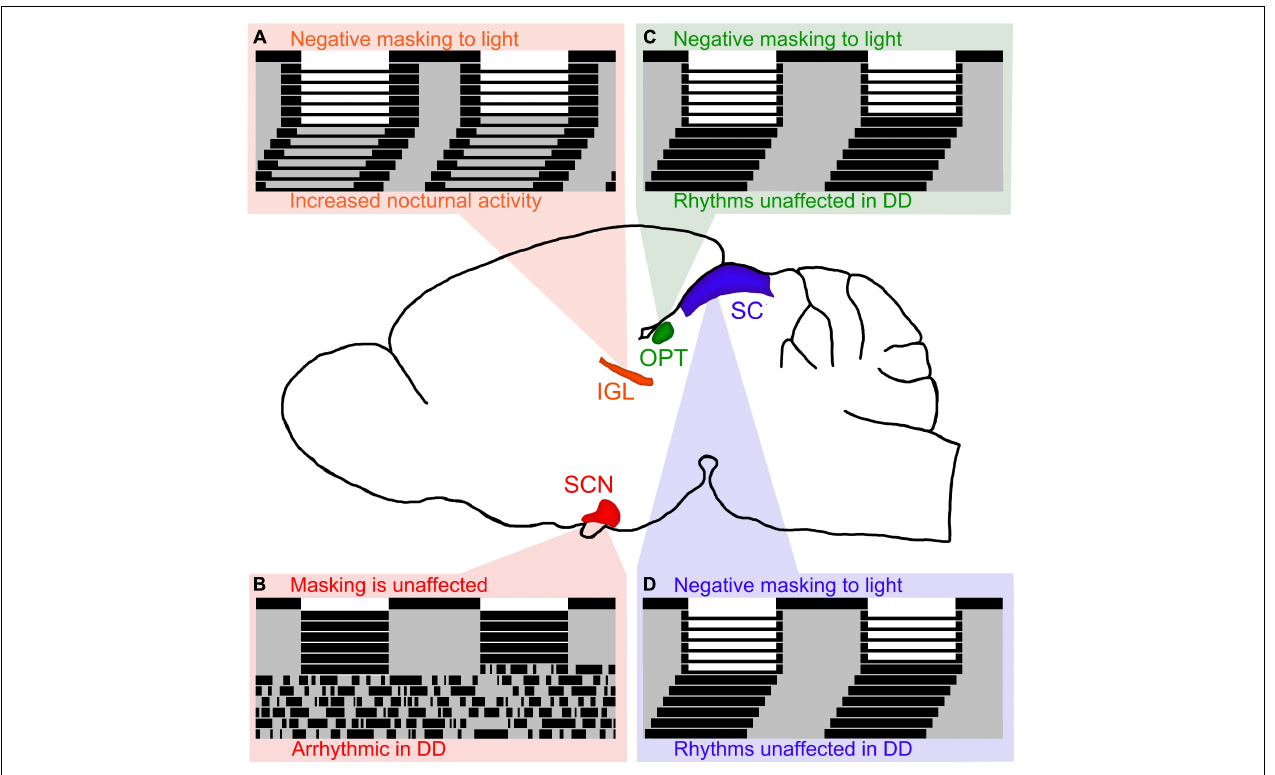
FIGURE 2 | Lesions of retinorecipient brain areas in Nile grass rats, a diurnal species, results in differential effects on masking and circadian rhythms. (A) Intergeniculate leaflet (IGL) lesions in Nile grass rats result in negative masking to light and increased nocturnal activity persists in DD (figure redrawn from Gall et al., 2013). Of the 4 retinorecipient brain areas lesioned thus far in Nile grass rats, the IGL is the only brain region that affects both masking and circadian rhythms in significant ways. (B) Suprachiasmatic nucleus (SCN) lesions in Nile grass rats result in arrhythmia in constant darkness (DD), but does not affect masking to light (figure redrawn from Gall et al., 2016). (C) Olivary pretectal nucleus (OPT) lesions in Nile grass rats result in negative masking to light, but circadian rhythms are unaffected (figure redrawn from Gall et al., 2017). (D) Similar to OPT lesions, lesions of the superior colliculus (SC) in Nile grass rats result in negative masking to light, but circadian rhythms are unaffected (figure redrawn from Gall et al.,